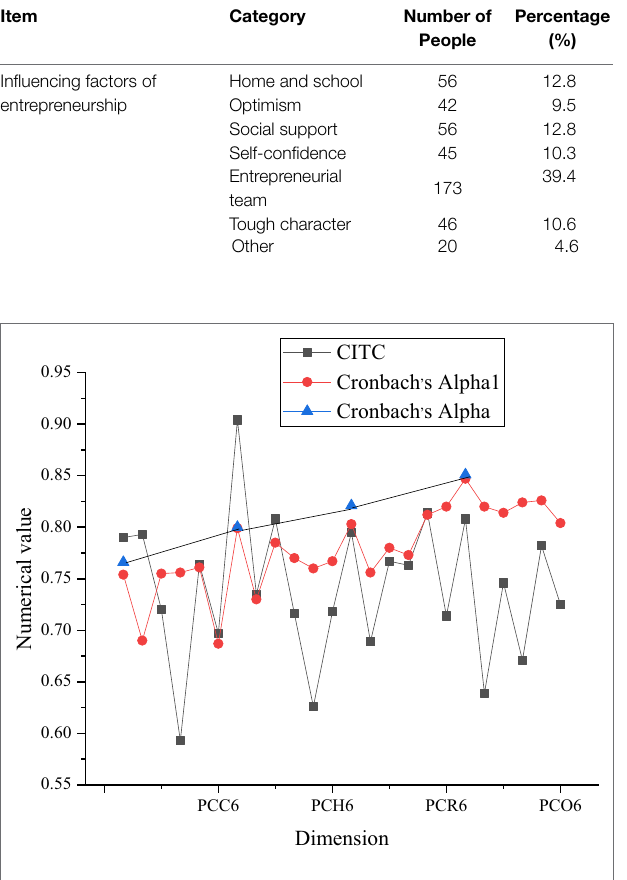
Figure 7 signifies reliability analysis results of the scale.